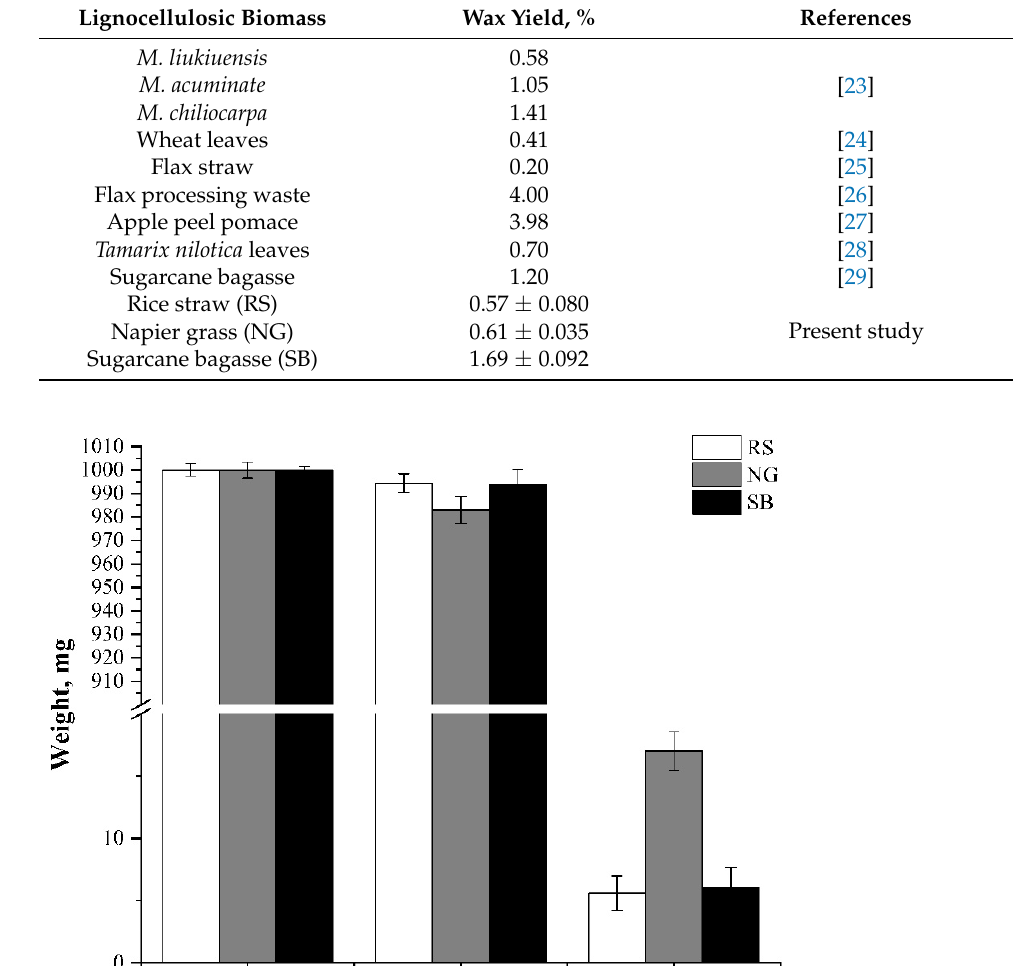
Table 1. Wax from different lignocellulosic biomass types extracted using n-hexane solvent.